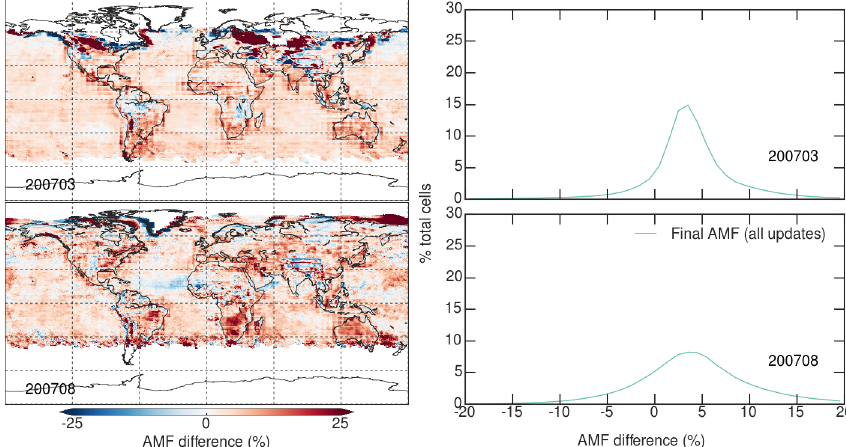
Figure 8. Left: spatial maps of the AMF differences resulting from the application of all AMF updates, as discussed in Sect. 5.8, relative to the default UoL AMF baseline algorithm (Sect. 4.3), i.e. 100% × (final AMF – baseline AMF)/baseline AMF. The AMFs are gridded to a 0.25 ◦ × 0.25 ◦ using observations with cloud fractions < 40%. Right: corresponding histograms of the AMF